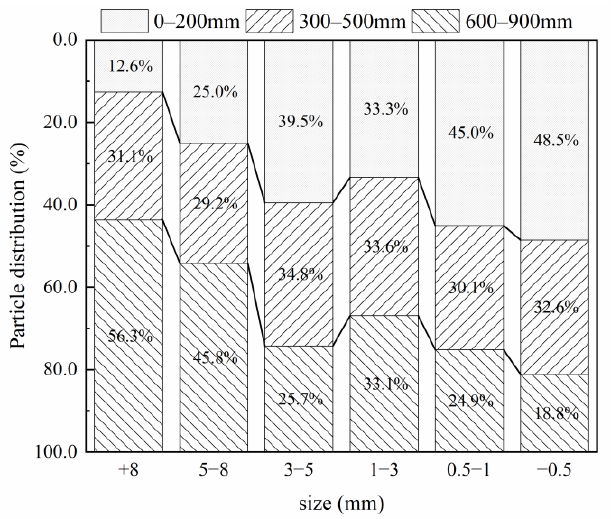
Figure 8. The particle size distribution of granules in the vertical direction of the bed.